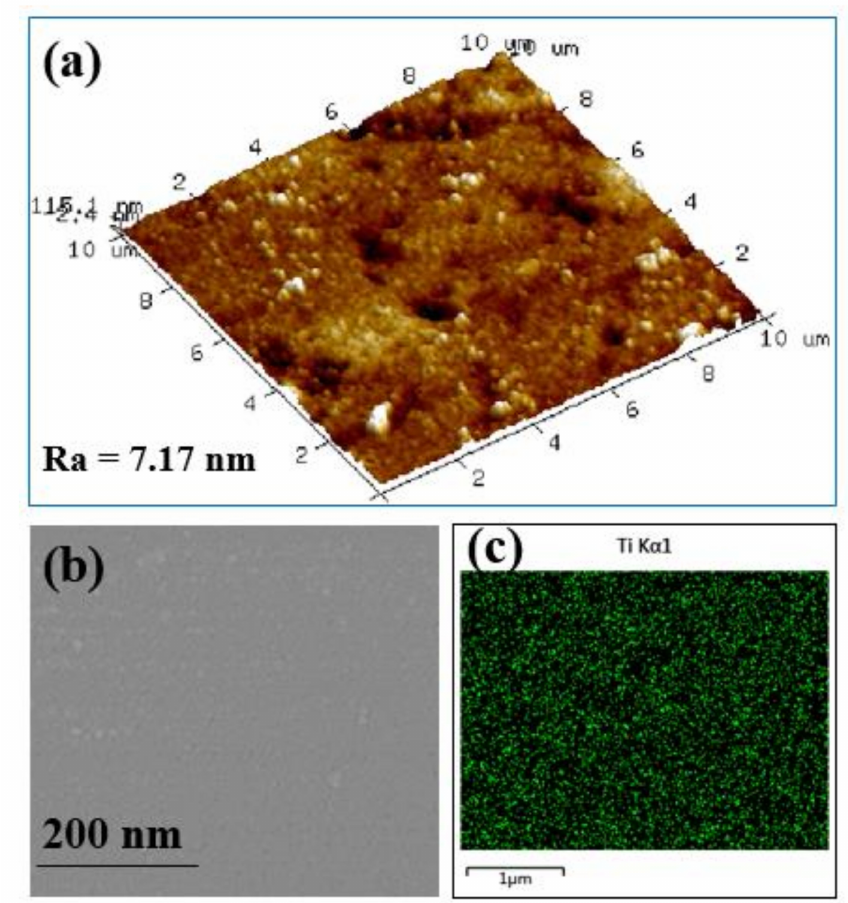
Figure 4. Novel organic-inorganic NF_PAN_Ti membrane ( a ) atomic force microscopy (AFM) image, ( b ) FESEM (field emission scanning electron microscopy), and ( c ) energy spectra of Ti